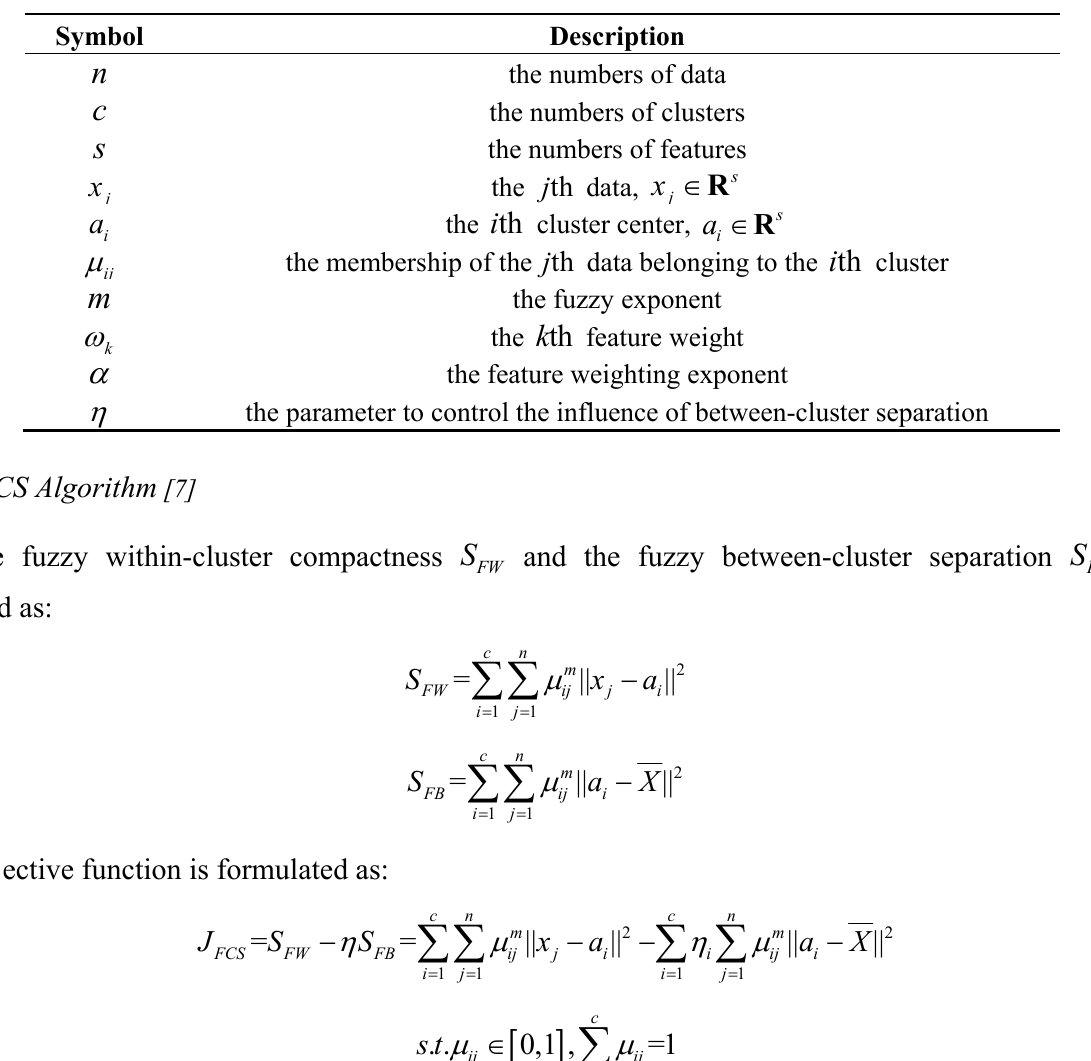
Table 1. Symbols